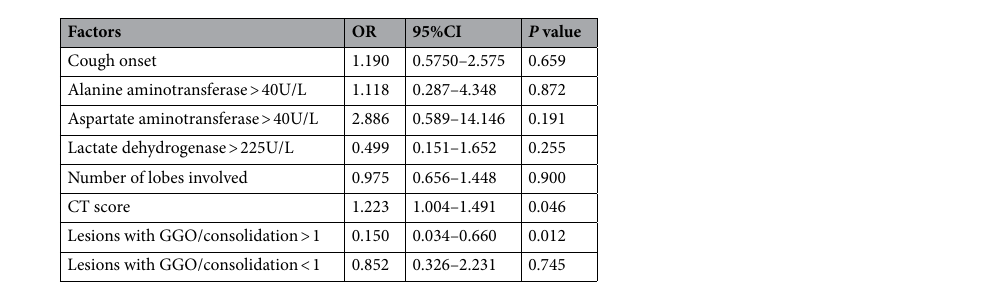
Table 3. Logistic regression analysis of risk factors and patients’ hospitalization